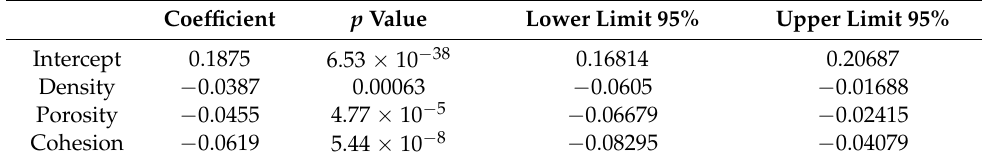
Table 3. T-test table for regression